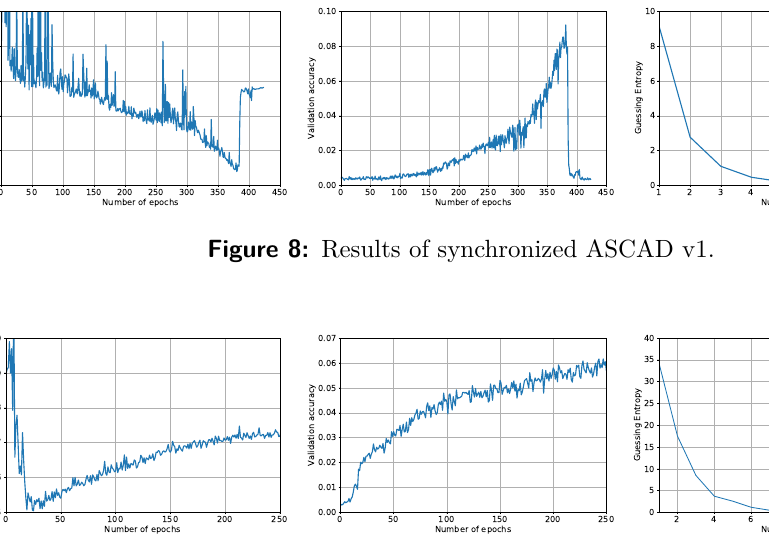
Figure 9: Results of synchronized ASCAD